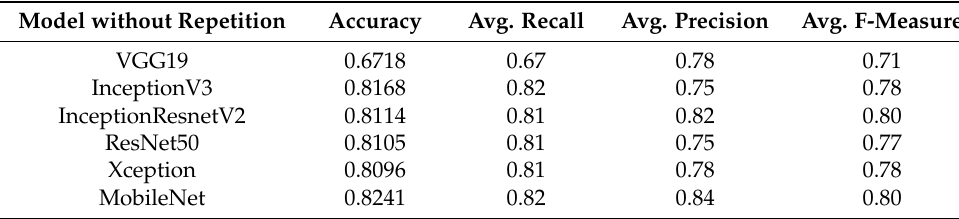
Table 2. Performance of transfer learning nets without repetition of images.